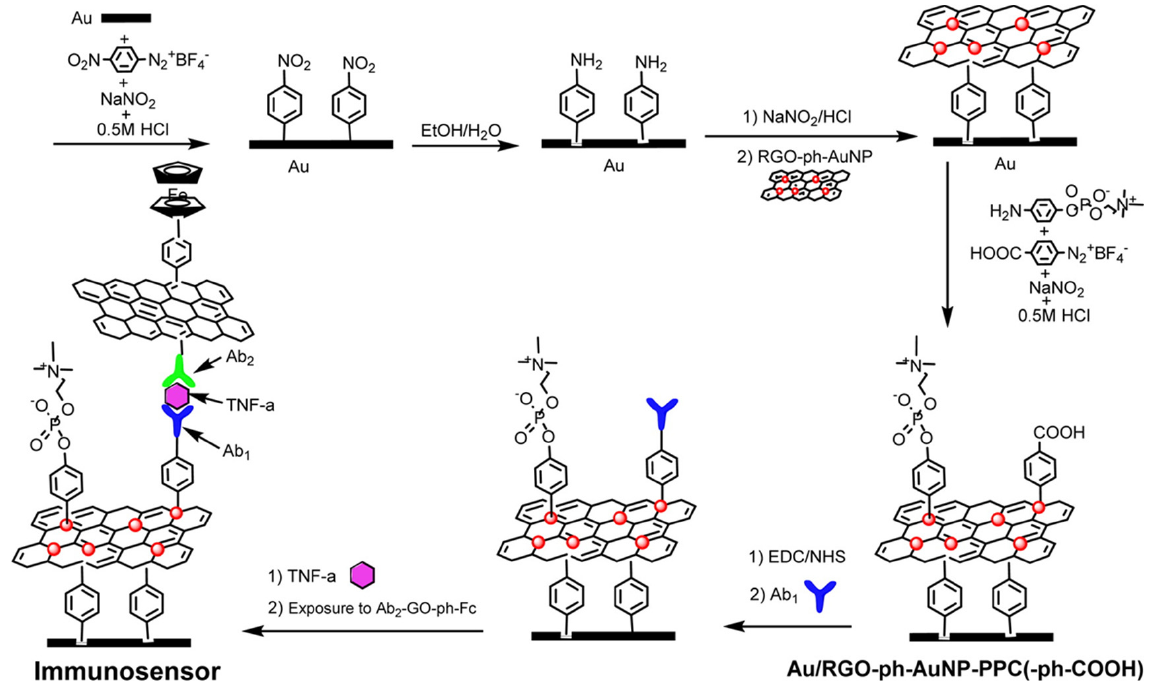
Figure 5. Sandwich-based immunosensor for the determination of TNF- α involving the use of Au-RGO-ph-AuNP-ph-PPC(-ph-COOH) as electrode modifiers and DAb-GO-ph-Fc as tracers. Reproduced from [34] with permission.